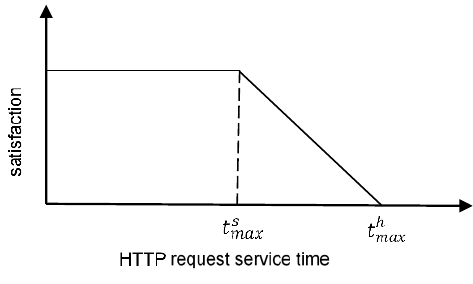
Figure 5. Satisfaction function.